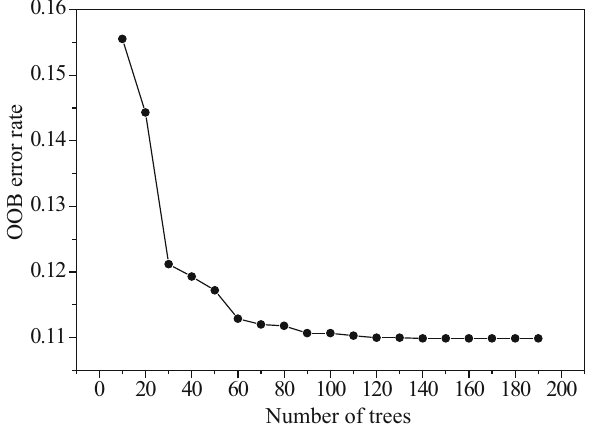
Fig. 2 Plot of OOB error rate against different number of trees in random